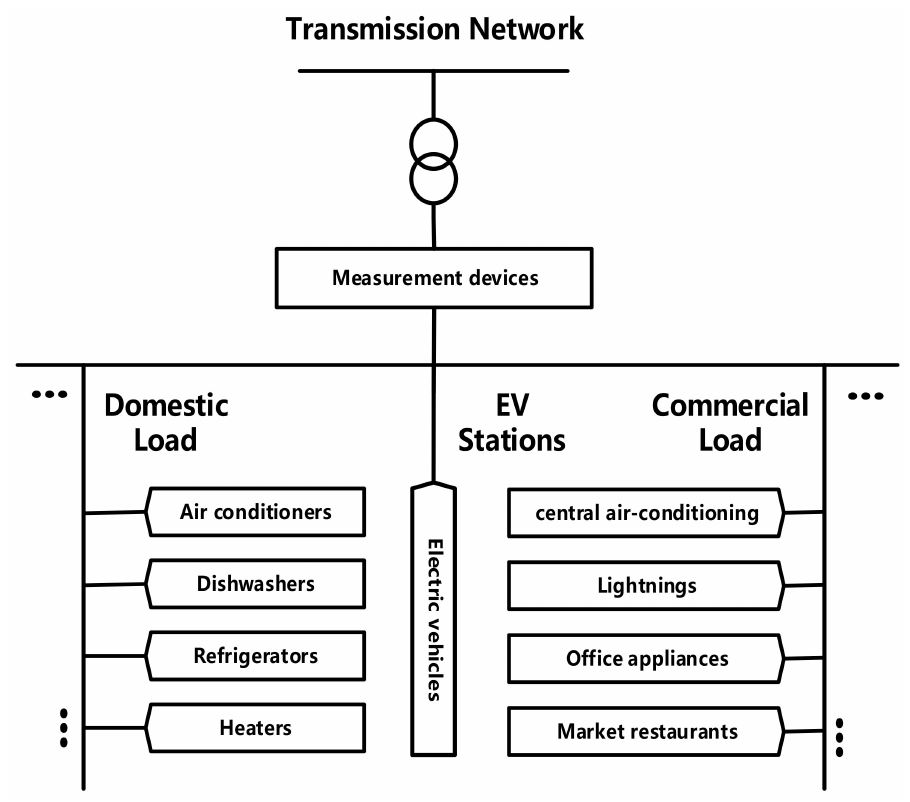
Figure 1. Load Disaggregation at Substation